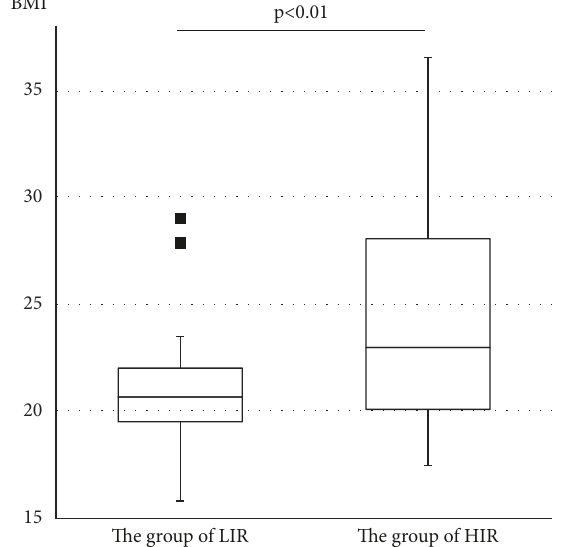
Figure 3: Comparison of BMI between the LIR and HIL groups. LIR group: women with low insulin resistance, HIR group: women with high insulin resistance. Comparison between groups was made using Welch’s t test. The black bar represents the median. The interquartilerangeisrepresentedbyabox.TheBMIoftheLIRgroup issignificantlylowerthanthatoftheHIRgroup.Thevalueexceeding 1.5 IQR was represented by closed square.